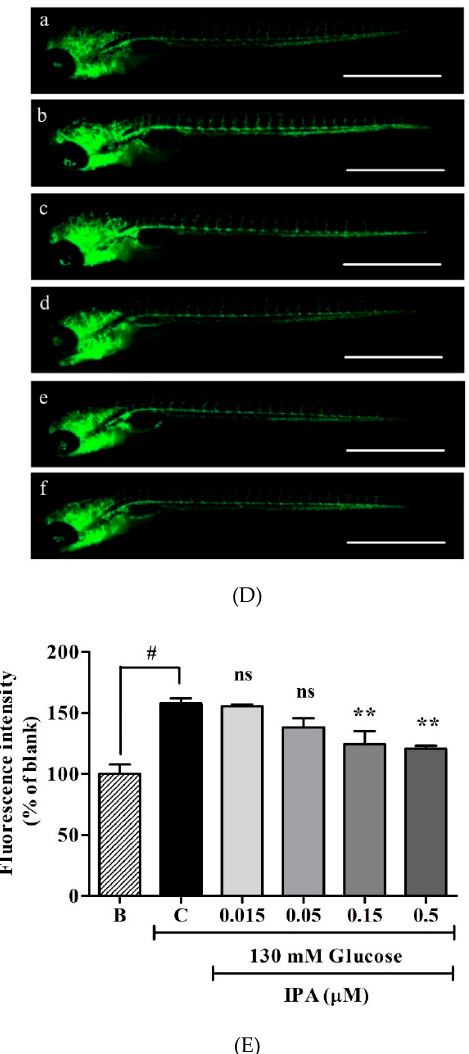
Figure 2. Effects of IPA on transgenic zebrafish ( flk :EGFP) embryos. ( A ) Effects of IPA on the survival rate of transgenic zebrafish ( flk :EGFP) embryos. The embryos were treated with 0.3, 1.5, 3, and 5 µM IPA for 24, 48, 72, 96, 120, 144, and 168 hpf. The treatment effects were normalized to blank (0 µM IPA). ( B ) Fluorescence microscopic images of the retinal vessels of transgenic zebrafish ( flk :EGFP) embryos treated with IPA. ( C ) The diameter of hyaloid retinal vessels treated with IPA. ( D ) The images of whole body vessel formation in transgenic zebrafish ( flk :EGFP) embryos treated with IPA as obtained by fluorescence microscopy. ( E ) Quantified fluorescence intensity of the whole body treated with IO extract (a: 0 mM glucose + 0 µM IPA, b: 130 mM glucose + 0 µM IPA, c: 130 mM glucose + 0.05 µM IPA, d: 130 mM glucose + 0.15 µM IPA, e: 130 mM glucose + 0.5 µM IPA, and f: 130 mM glucose + 1.5 µM IPA). The effects of 130 mM glucose on vessel formation were compared to B (blank (0 mM glucose + 0 µM IPA)). The effects of IPA on high glucose-induced vessel formation were normalized to C (control (130 mM glucose + 0 µM IPA)). Scale bar (B) 20 µm, (D) 1000 µm. ns; not significant, * p ˂ 0.05, ** p ˂ 0.01, # p ˂ 0.05.